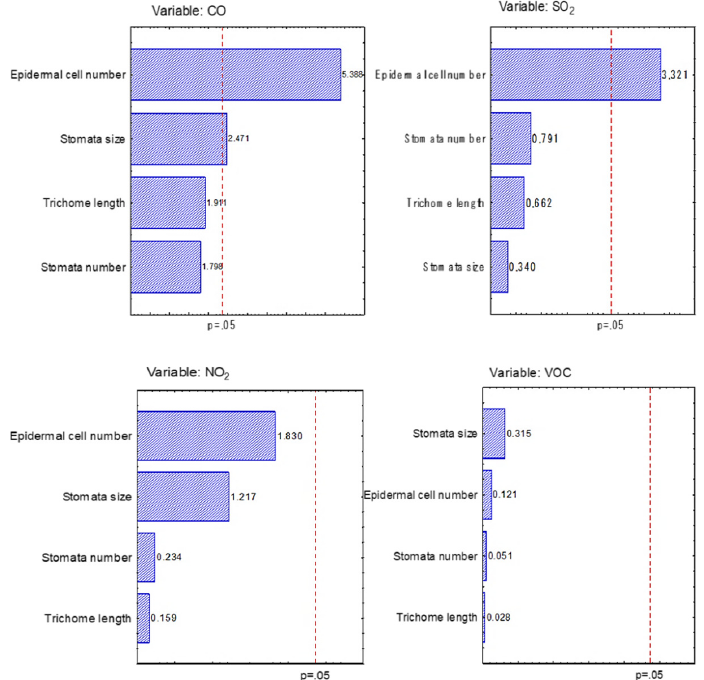
Figure 1. Pareto chart of t-values for coefficients from multiple regression for Terminalia